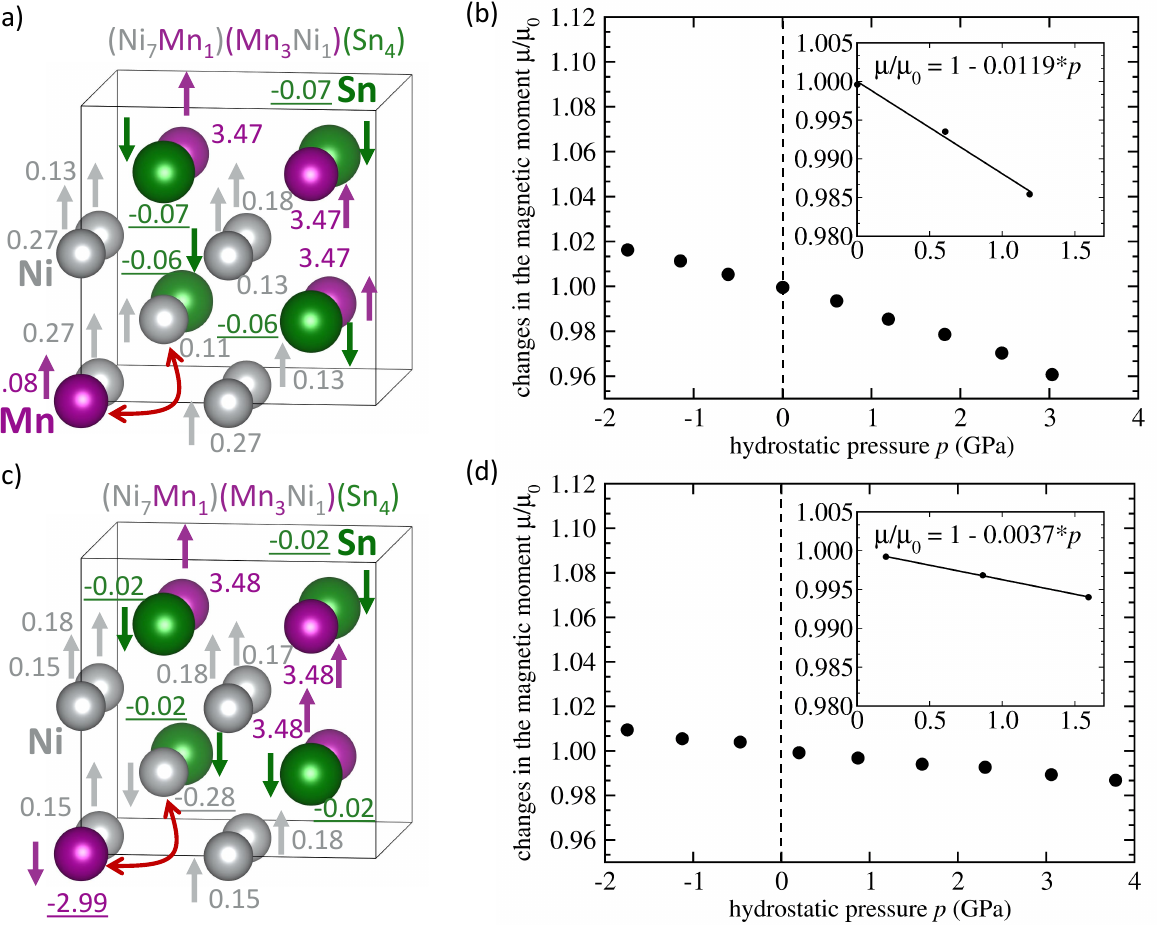
Figure 4. A schematic visualization of a 16-atom computational supercell of the austenitic stoichiometric Ni 2 MnSn ( a ) with one Mn atom swapping with one Ni atom (indicated by the red arrow) with the local magnetic moments of the swapped Mn atom having the orientation equal as that of the Mn atoms at the Mn sublattice. Part ( b ) shows calculated pressure-induced changes of the total magnetic moment of this state (the computed data points are accompanied by a linear fit and its parameters). Figure ( c ) shows a state with the swapped Mn atom having its local magnetic moments anti-parallel to those of Mn atoms on the Mn sublattice. Part ( d ) exhibits calculated pressure-induced changes of the total magnetic moment of the state shown in part ( c ) together with the corresponding linear fit. Magnitudes of local magnetic moments are listed in Bohr magnetons and negative underlined values mean antiparallel